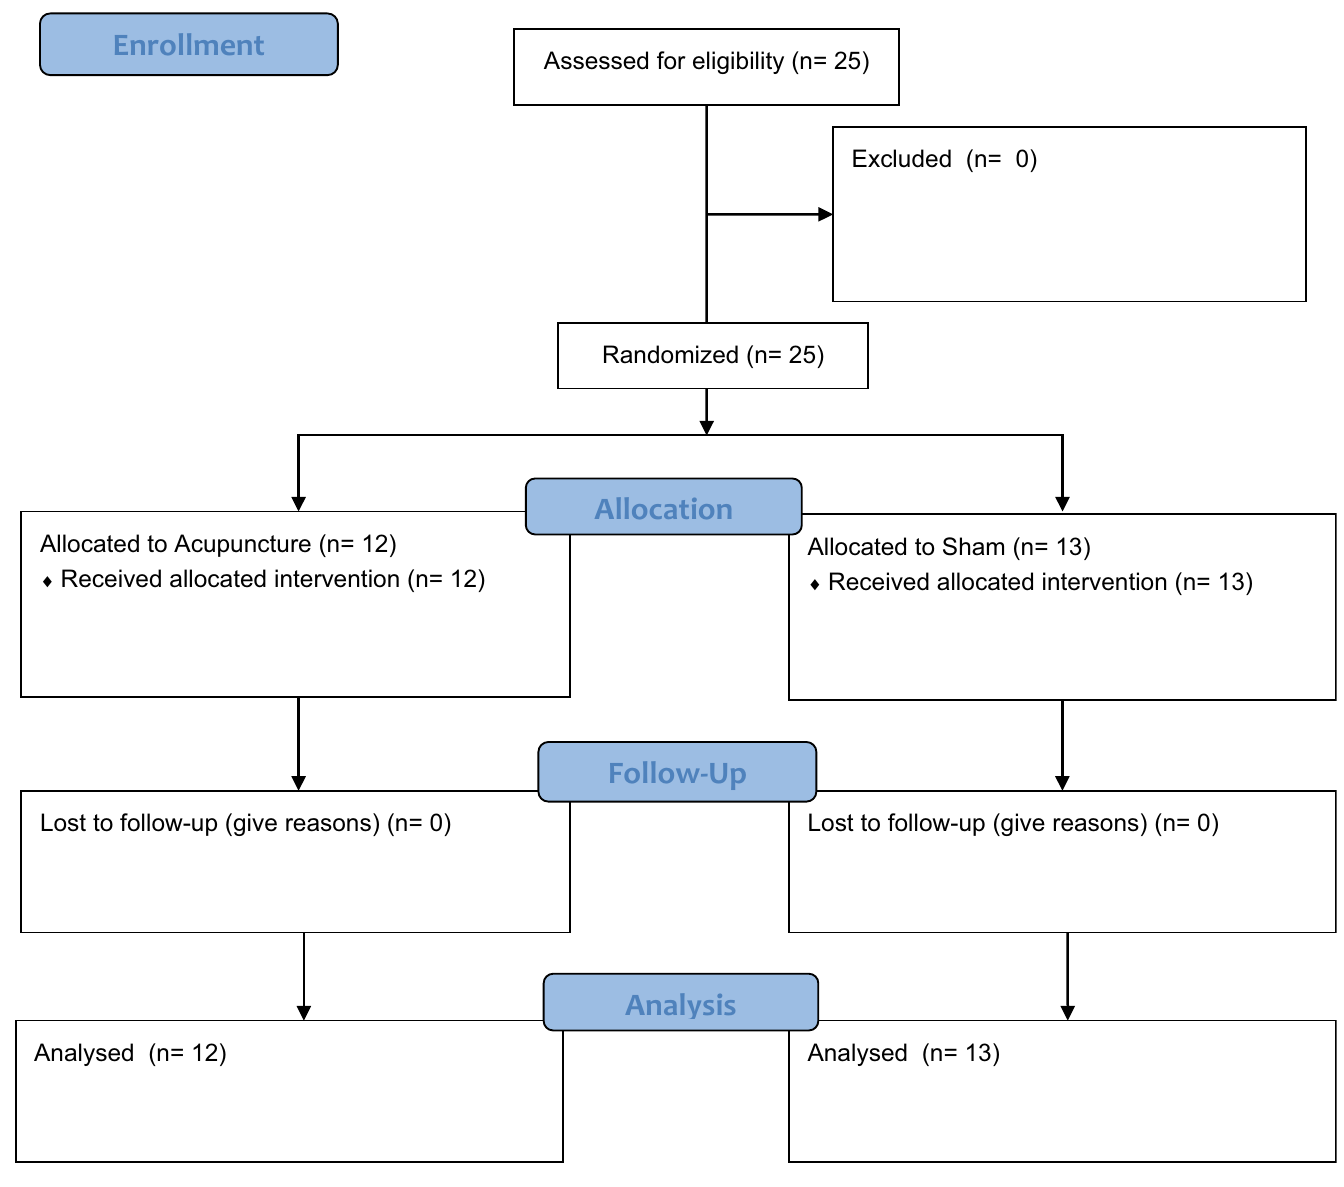
Fig 1. Consort study flow